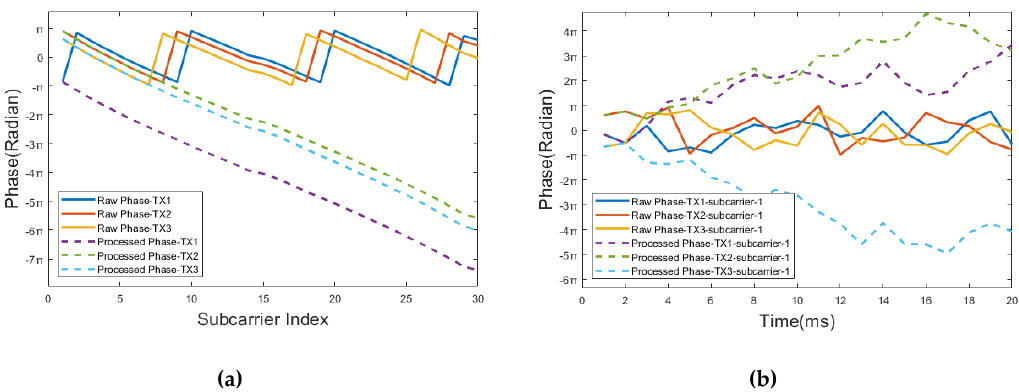
Figure 15. Raw vs. pre-processed CSI phase ( a ) CSI phase vs. subcarrier index ( b ) CSI phase vs. sampling time.